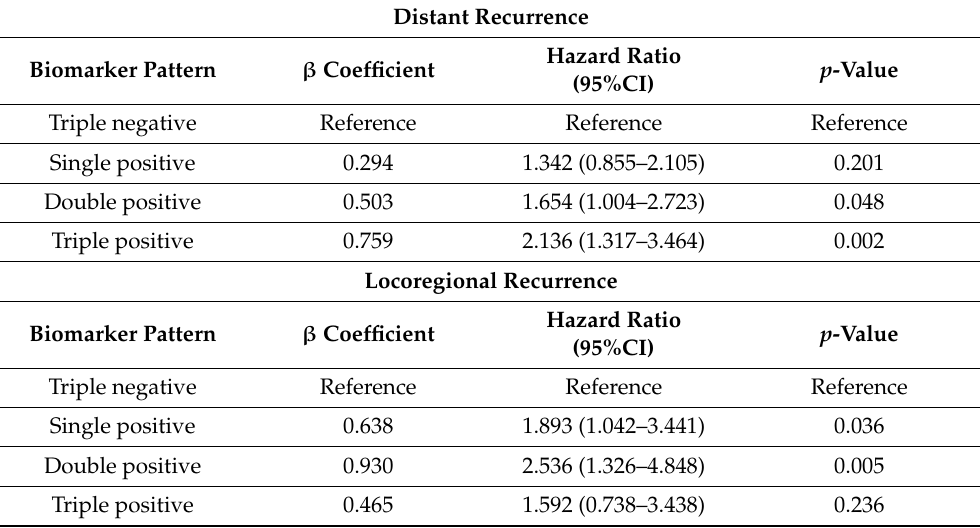
Table 2. Biomarker panel and hazard of distant and locoregional recurrence in the APGI/ICGC